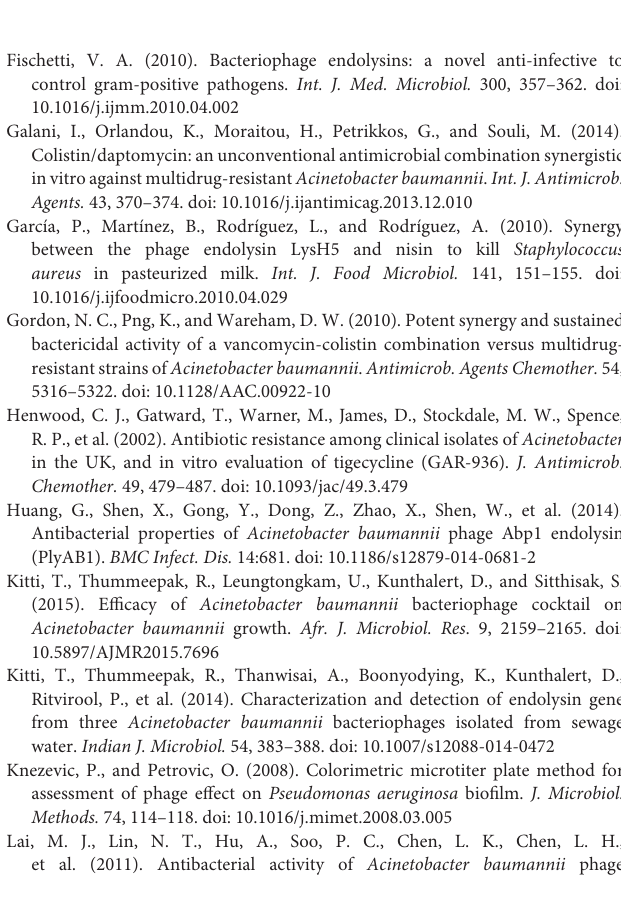
FIGURE S1 | In vitro synergistic activity of LysABP-01 combined with colistin against XDRAB strains. (A) The representative checkerboard plates. (B) The isobolograms representing the drug interaction of LysABP-01 plus colistin. FIC values derived from combinations of LysABP-01 and colistin were used to plot the isobologram. The dashed line illustrates the theoretical additive interaction between two agents. TABLE S1 | MICs of conventional antibiotics against A. baumannii AB